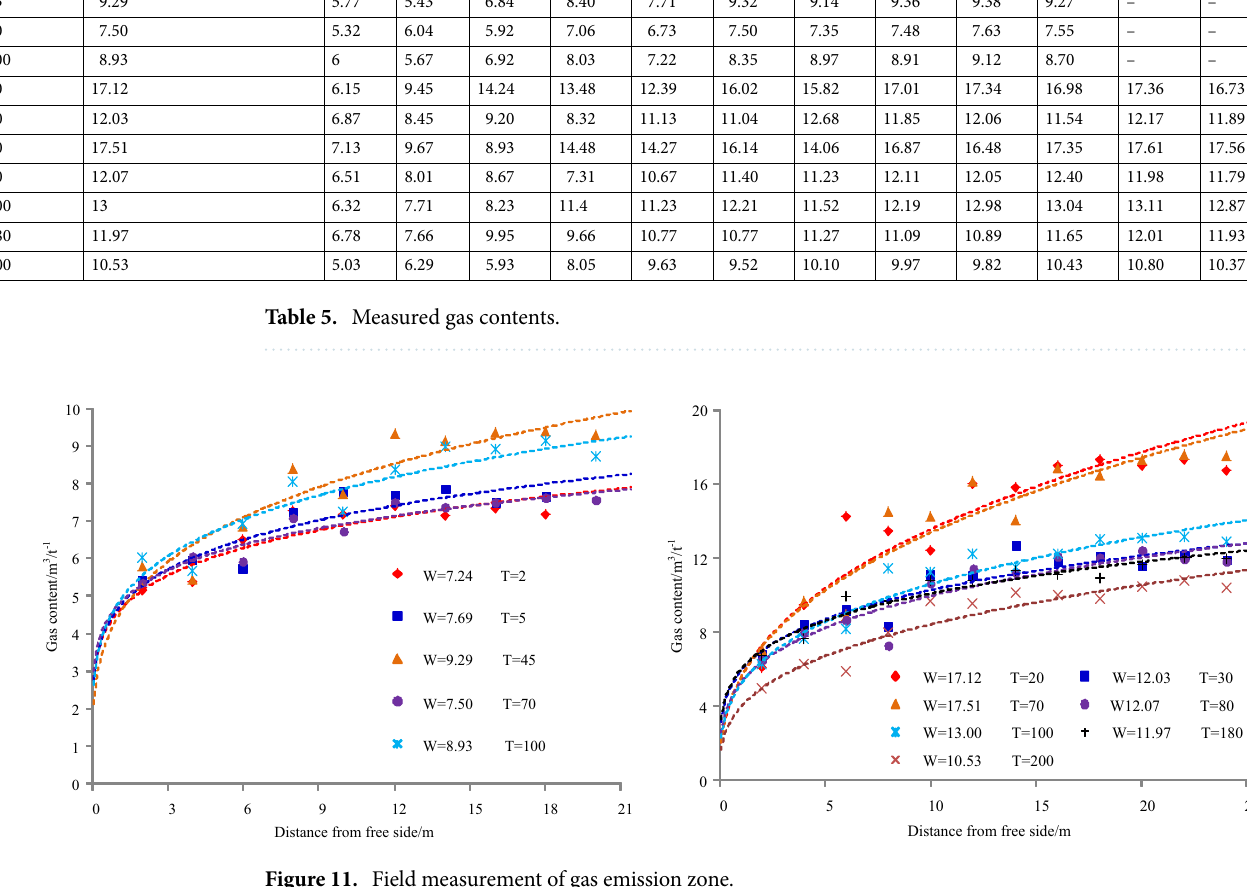
Figure 11. Field measurement of gas emission